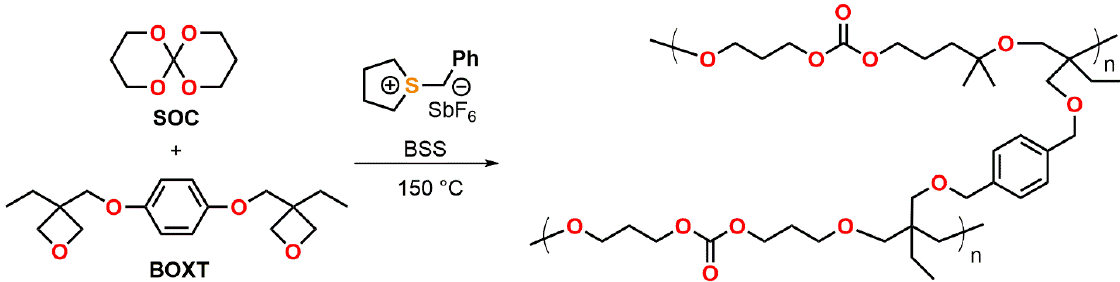
Figure 18. Thermally initiated, cationic copolymerization of a SOC with the bifunctional oxetane BOXT.